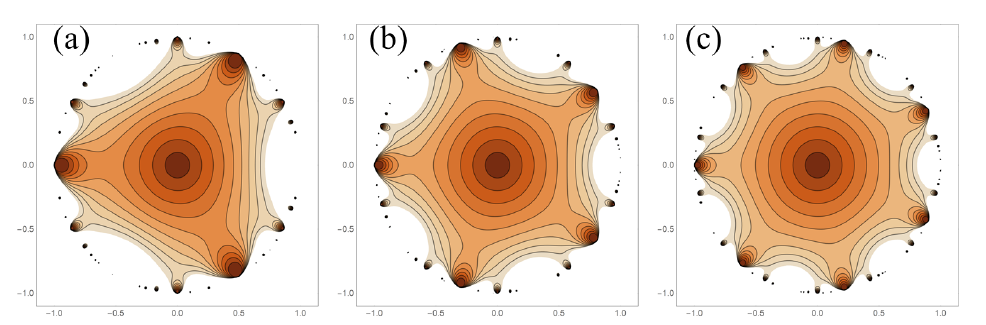
Figure 2. The example of lacunary functions generated from the centered polygonal numbers. Panel ( a ) shows the case for k = 3, N = 20. Panel ( b ) shows the case for k = 5, N = 20. Panel ( c ) shows case for k = 7, N = 20. In all cases, the true rotational symmetry and dihedral mirror symmetry are clearly